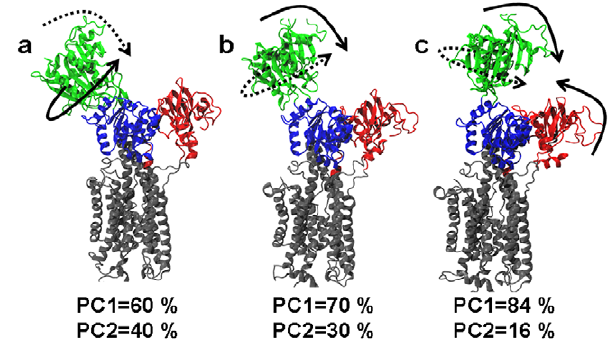
Figure 7. Directionality of motions along the open-to-closed transition of Ca 2 + -bound SERCA. The motions correspond to (a) region 1, (b) region 2 and (c) region 3 of the energy landscape (Fig. 6B). Dashed and solid arrows represent motions described by the first and second principal components (PC1 and PC2), respectively. The percentage of contribution of each principal component (PC) that belongs to the essential space is shown below each structure.